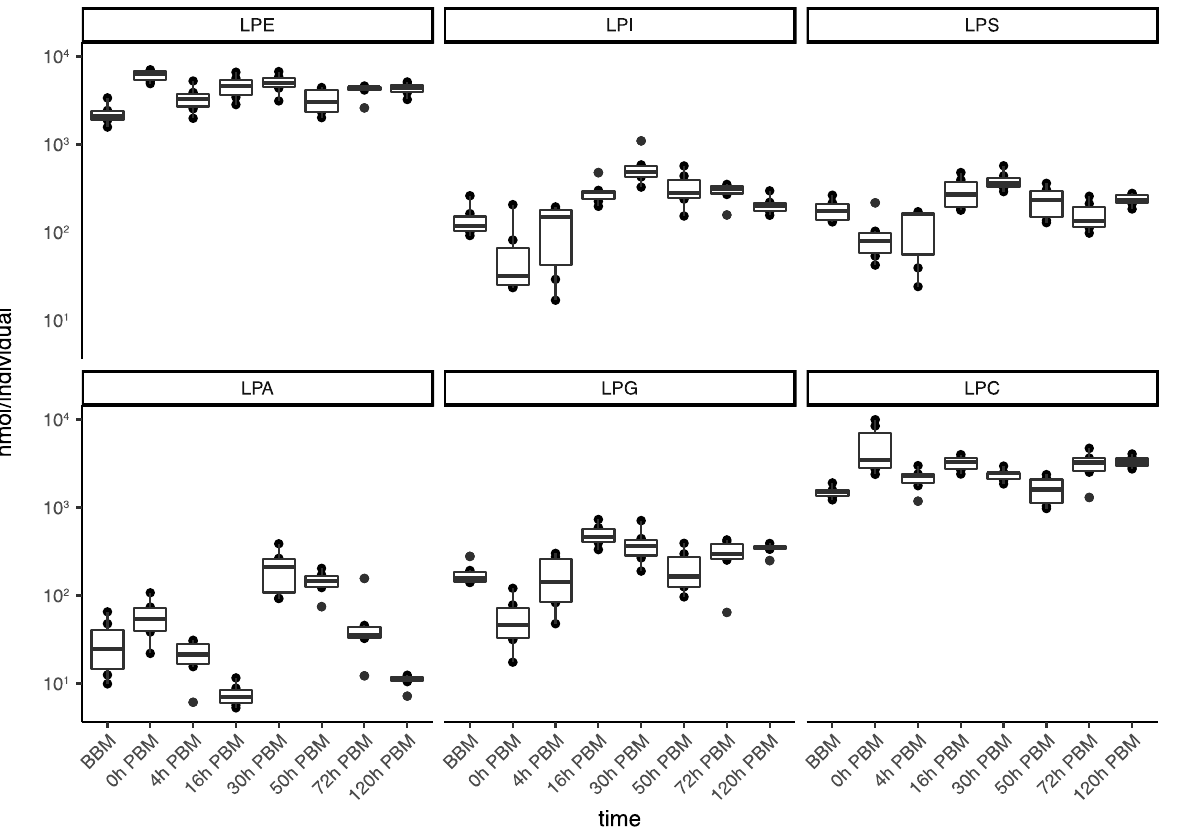
Figure 5. Changes of lipid amounts in lyso-glycerophospholipids in Aedes aegypti females over the course of feeding and reproduction. The total amount (nmol/individual) of lyso-phosphatidylethanolamine (LPE), lyso- phosphatidylinositol (LPI), lyso-phosphatidylserine (LPS), lyso-phosphatidic acid (LPA), lyso-phosphatidylglycerol (LPG) and and lyso-phosphatidylcholine (LPC) were measured at eight time points before blood meal (BBM) and post blood meal (PBM).